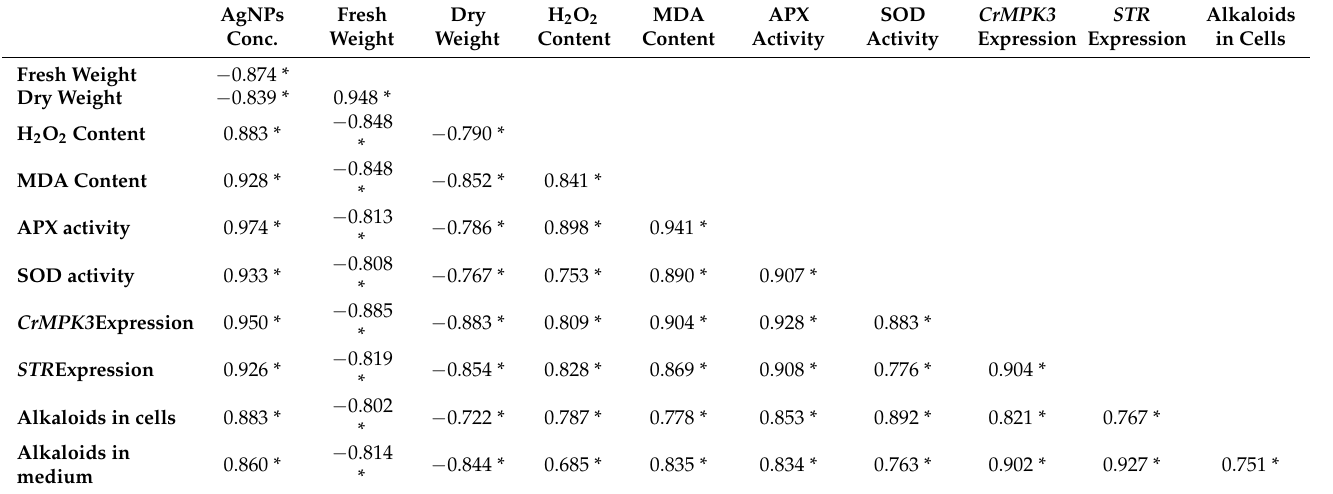
STR Alkaloids Expression in